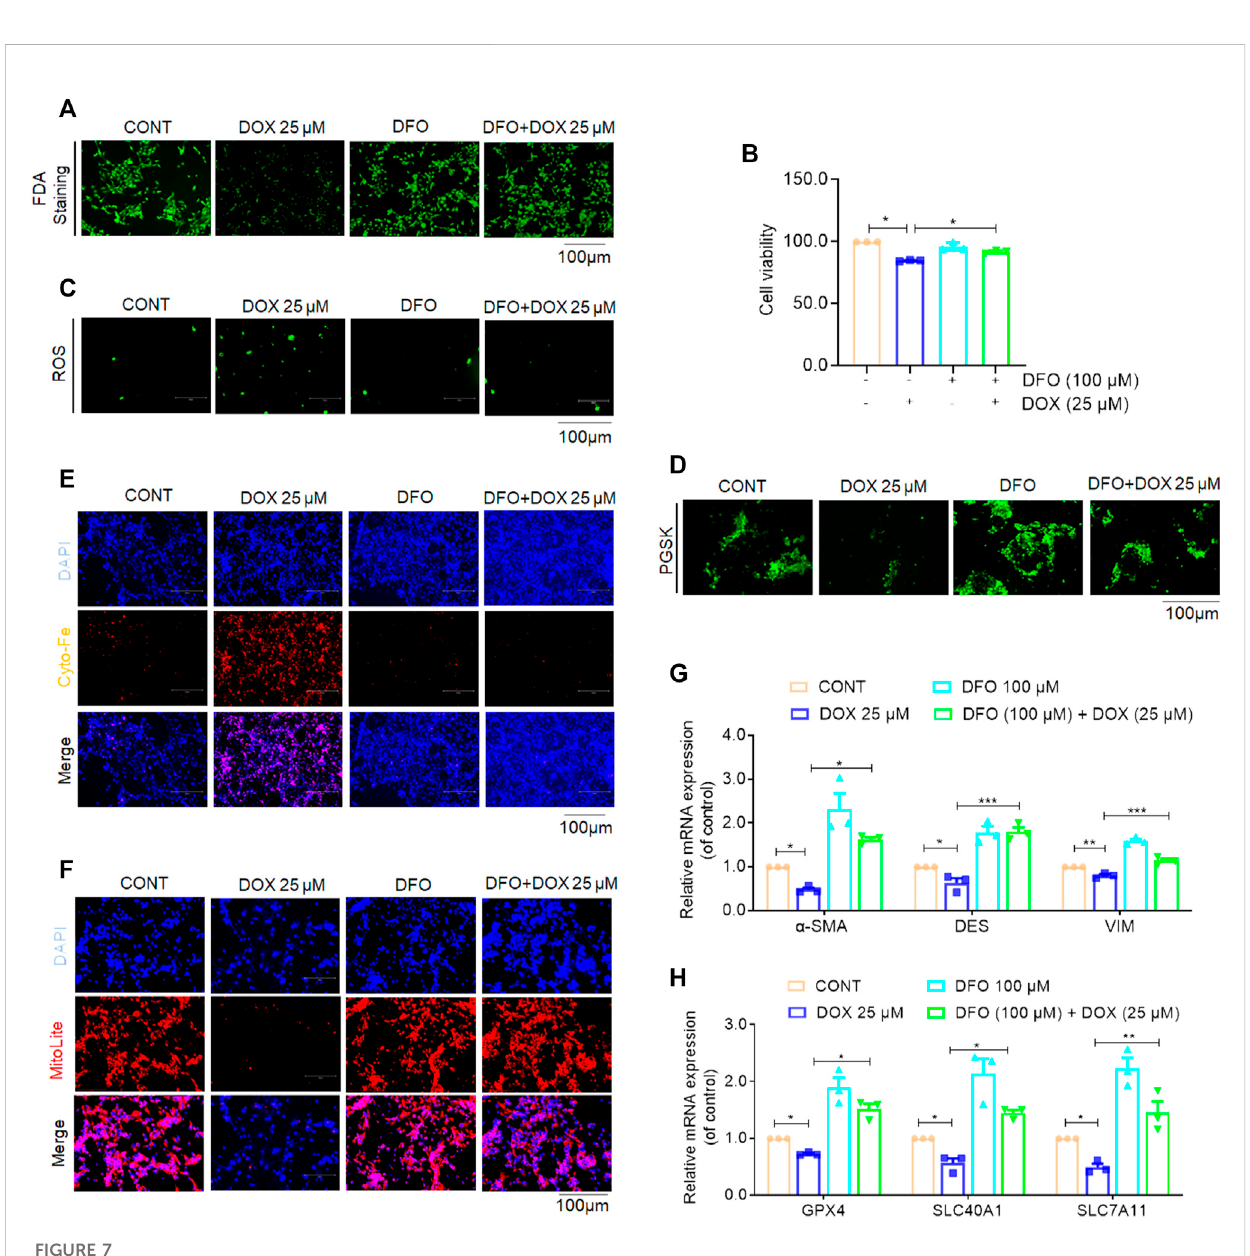
Inhibition of ferroptosis impaired DOX-induced anti- fi brosis effects in vitro . Activated LX-2 cells were exposed for 24 h to 100 μ M DFO followed by 25 μ M DOX treatment. (A) FDA staining for evaluating cell death. LX-2 was stained in 10 μ M FDA and the samples were observed with a fl uorescence inverted microscope. (B) Cell Count Kit-8 analysis of cell viability in LX-2. CCK-8 was incubated with LX-2 at 37 ° C for 1 h and the samples was measured using a multifunctional enzyme labeler at 405 nm. (C) The ROS level in LX-2. LX-2 was stained in 10 μ M DCFH-DA in DMEM for 1 h at 37 ° C and the samples were observed with a fl uorescence inverted microscope. (D) Free iron levels in LX-2 were measured by Phen Green SK probe. LX-2 cells were stained in 10 μ M Phen Green SK in PBS for 1 h at 37 ° C and the samples were imaged immediately. (E) Representative fl uorescent images of intracellular iron level were identi fi ed by using FerroOrange (orange). Nuclei are stained by DAPI (blue). LX-2 was stained in 1 mM Ferro orange in PBS for 1 h at 37 ° C and samples were imaged immediately. All samples as described (D,E) were observed with a fl uorescence inverted microscope. (F) Mitochondrion staining detection. LX-2 cells were stained in the buffer containing a 1:500 dilution of MitoliteTM Red FX600 for 1 h at 37 ° C and the samples were observed with a fl uorescence inverted microscope. (G) The mRNA expression of α -SMA, DES and VIM ( n = 3). (H) The mRNA expression of GPX-4, SLC40A1 and SLC7A11 ( n = 3). For the statistics of each panel in this fi gure, data were expressed as means ± SEM. * p < 0.05; ** p < 0.01; *** p < 0.001.